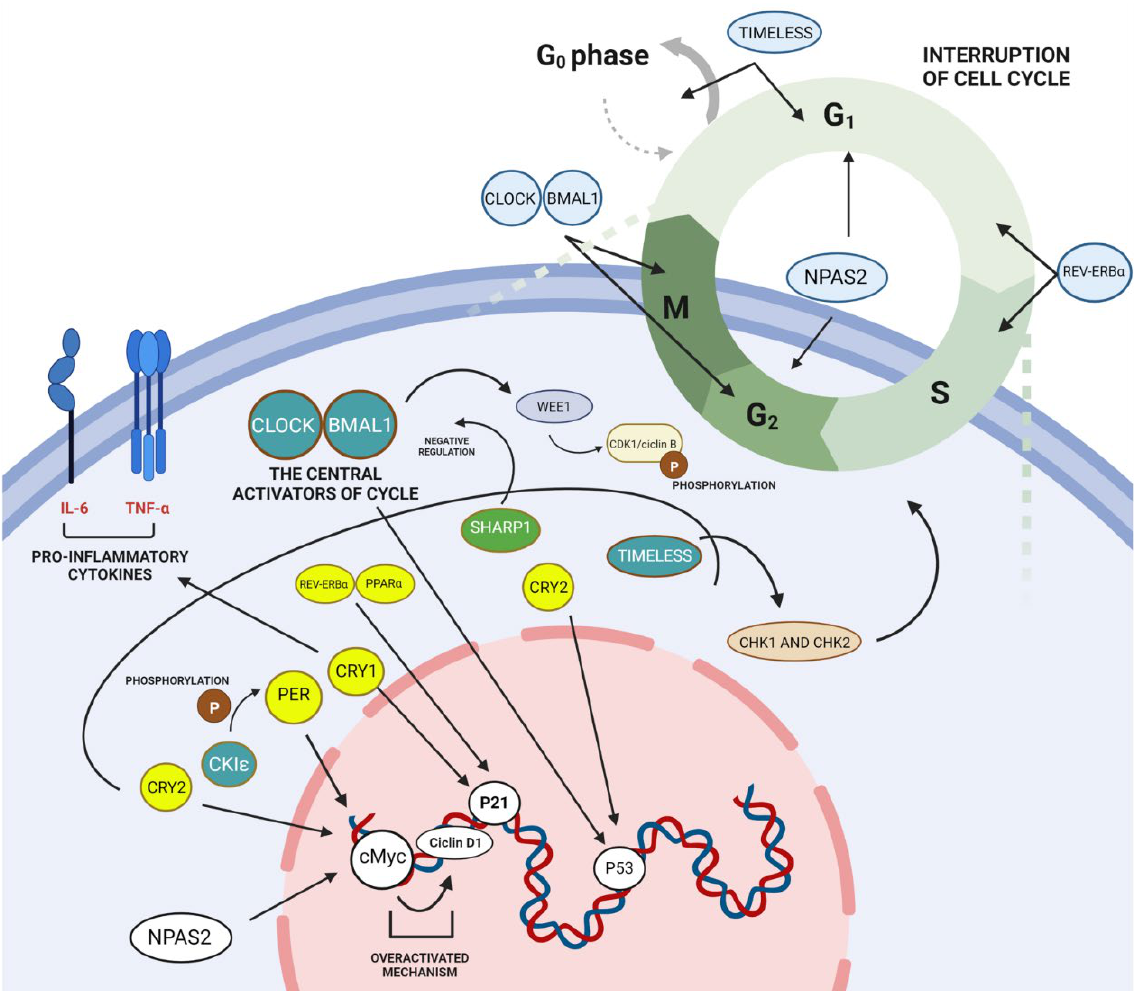
Figure 2. Role of clock genes in leukemic transformation. The CLOCK-BMAL1 complex promotes the expression of clock genes and changes in the circadian clock. Furthermore, at high expression levels, CLOCK-BMAL1 can directly affect Wee1, which phosphorylates CDK1/cyclin B, interfering at the cell cycle transition from the G2 to the M phase. In addition, some circadian clock genes were reported at low levels, represented in yellow as PER, which altered the expression of cMyc, which is closely linked to cyclin D1. This also happens with NAPS2, which affects cMyc-Cyclin D1, leaving it overactivated. Cry1 presents a low-level expression that directly affects the expression of p21 and pro-inflammatory cytokines such as TNF- α and IL -6. Also at low expression levels, Cry2 can affect cMyc expression, which again supports its overactivity. In addition, Cry2 also affects p53 expres- sion. Low levels of REV-ERB α and PPARα can also be correlated with changes in p21 expression. Furthermore, the REV- ERBα gene can also inhibit the cell cycle transition from the G1 to the S phase. The SHARP1 at high expression levels, as represented in green, has a correlation with the negative expression of CLOCK-BMAL1. The TIMELESS gene is also an important molecular biomarker, which—according to the studies—can present a high or low expression, participate in cell cycle checkpoints, and regulate Chk1 and Chk2, so it can cause an interruption in the G0 and G1 phases of the cell cycle. Finally, another gene that was shown to be at high and low levels was the CKIε gene, which—at its high levels—plays a role in the phosphorylation of the PER gene. Created with BioRender.com 5. Conclusions In this review, clock genes have been proven to have an important influence on cell cycle progression, and consequent dysfunctions in CGs lead to changes in the normal cell functioning, often inducing constant cell proliferation and preventing apoptosis. PER1/2/3 , BMAL1 , CLOCK , REV- ERBα , and PPARα were downregulated in all types of